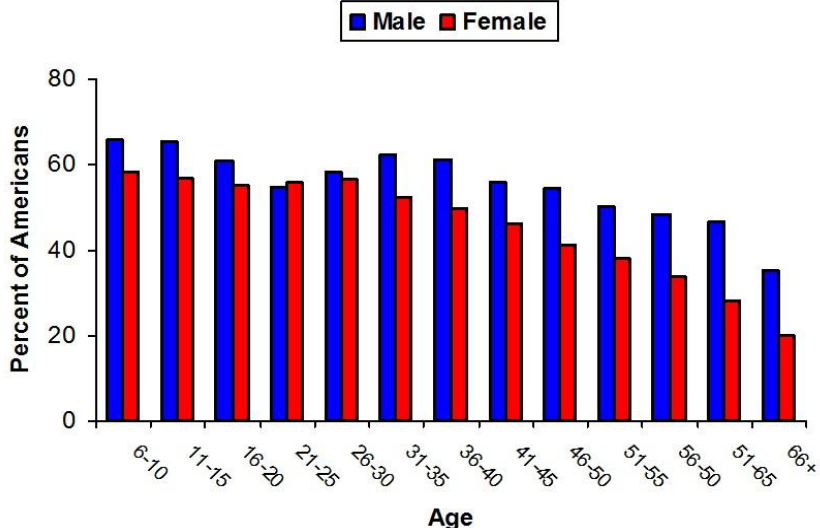
Figure 10. The percentage of American people by age and gender who engage in outdoor recreation pursuits [15].